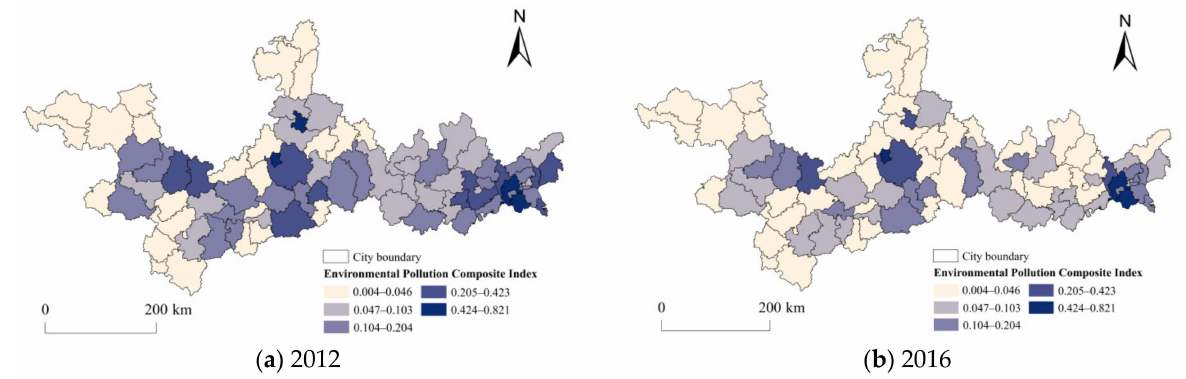
Figure 4. Spatial distribution of EPCI at the county scale in the